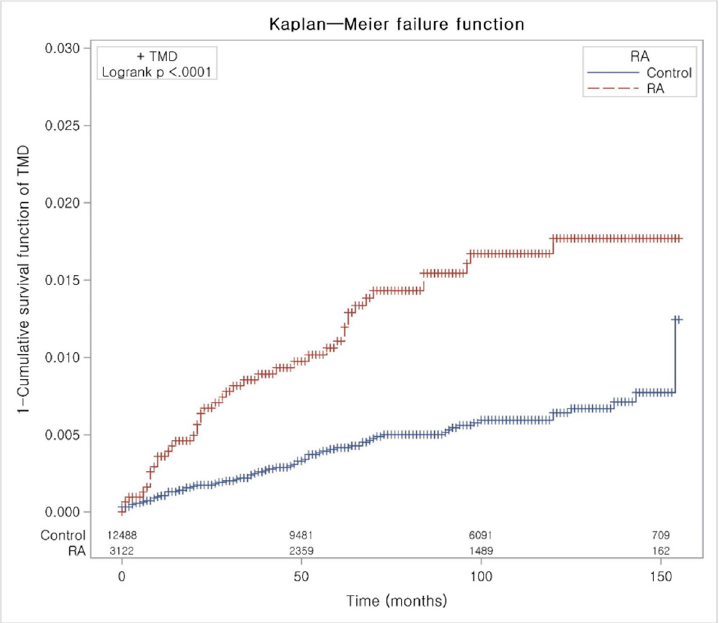
Figure 2. Kaplan-Meier curve of temporomandibular disorder in patients with rheumatoid arthritis. This is a 1 – survival function curve. TMD—temporomandibular disorder; and RA—Rheumatoid arthritis.